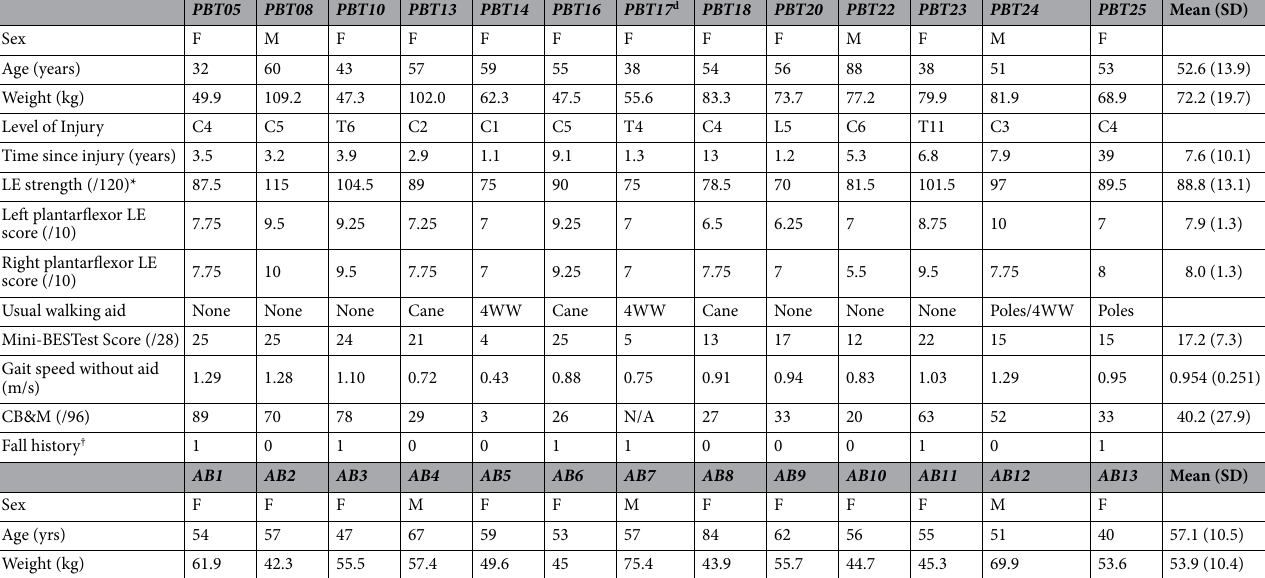
Table 1. Summary of participant information such as age, level of impairment, time since injury, and clinical scores. LE lower extremity, mini-BESTest mini-Balance Evaluation Systems Test, CB&M Community Balance and Mobility Scale, C cervical, T thoracic, L lumbar, 4WW 4-wheeled walker. d Denotes participant excluded from data analyses, due to inability to complete CB&M assessment. *LE strength measured with manual muscle testing of 12 muscles per LE. Maximum score per muscle is 5, resulting in a total score of 120 for 2 LE. † Denotes retrospective falls in the previous 3